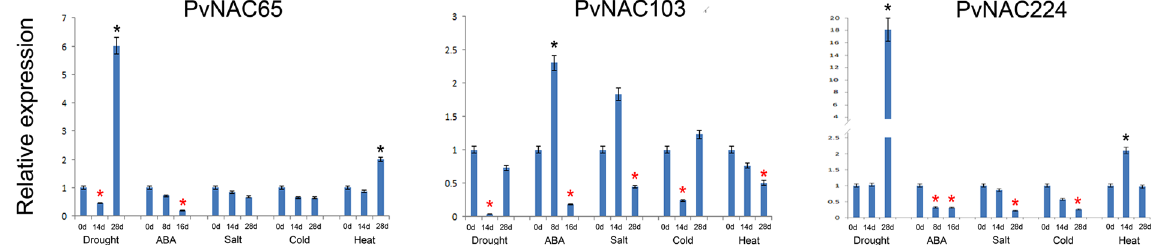
Figure 6. The expression analysis of three selected PvNAC s based on array data relating to ABA and drought, salt, cold, and heat stresses through qRT-PCR. Relative expression of these PvNAC s were normalized in relation to reference gene UCE2 in different stresses. The bars represent error bar. The black * represents the expression for treatment group is more than twice as control group (0 d), while red * represents treatment group is below half of the control group (0